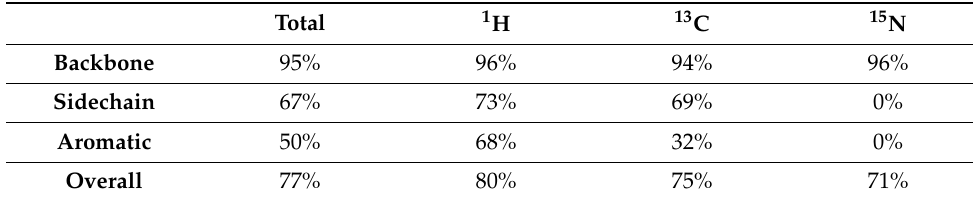
Figure 2. 15 N{ 1 H} NOE values, with I/I0 ratios representing the individual amide signal intensity with and without hydrogen saturation. The horizontal dotted line marks the average ratio value. Ratios below the average line indicate regions of mobility in the protein. The main regions of flexibility correspond to the supposed CDR1 (positions 26 − 31), a supposed loop between positions 42 and 45, and the supposed initial part of the CDR3 (positions 102 − 106). Residues with no bar correspond to either prolines (Pr041 and Pro88) or residues which were missing NH assignment. Based on the NOE values obtained for peaks (a), (b), and (c), that did not show scalar correlation in 3D spectra (Figure 1), a tentative assignment is proposed, respectively Gln1, Thr28, and Ser63, as indicated by the positions of the red bars. Table 1. Chemical shift assignment